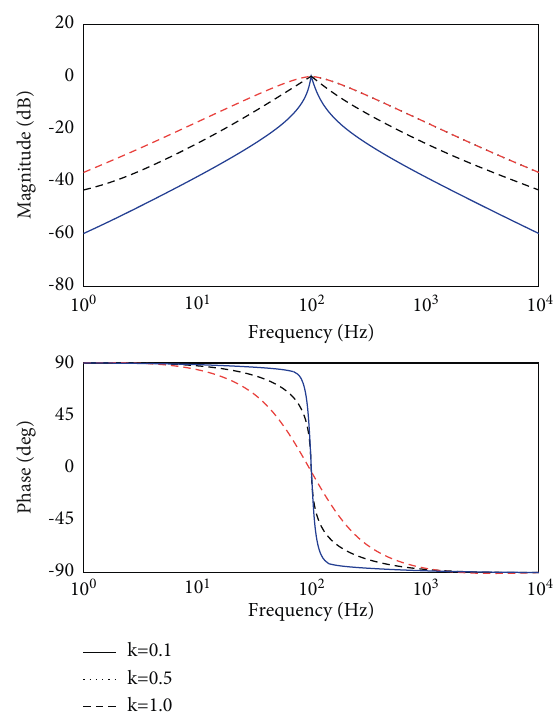
Figure 3: The bode diagram of the band-pass filter implemented by SOGI at different k